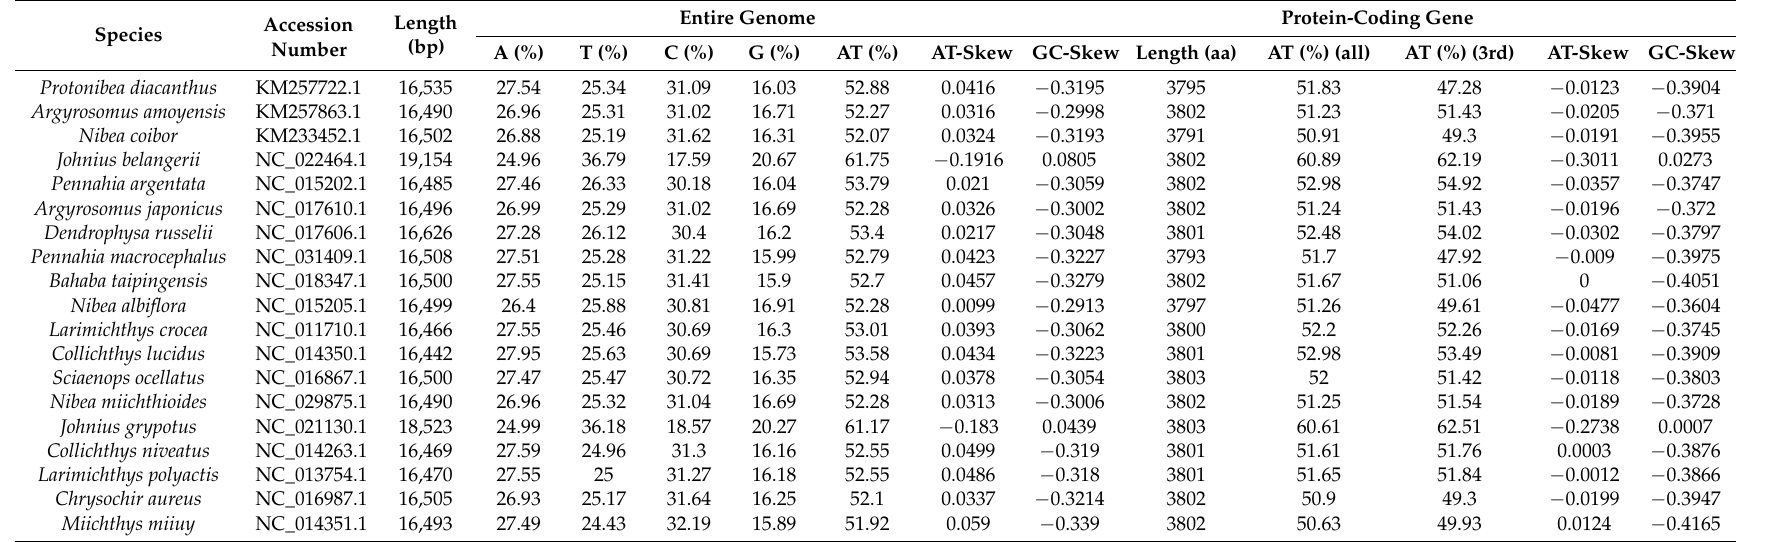
Table 1. Summary of the base composition of the mitogenomes at each codon position of the concatenated 13 protein-coding genes (PCGs) across 19 species of family